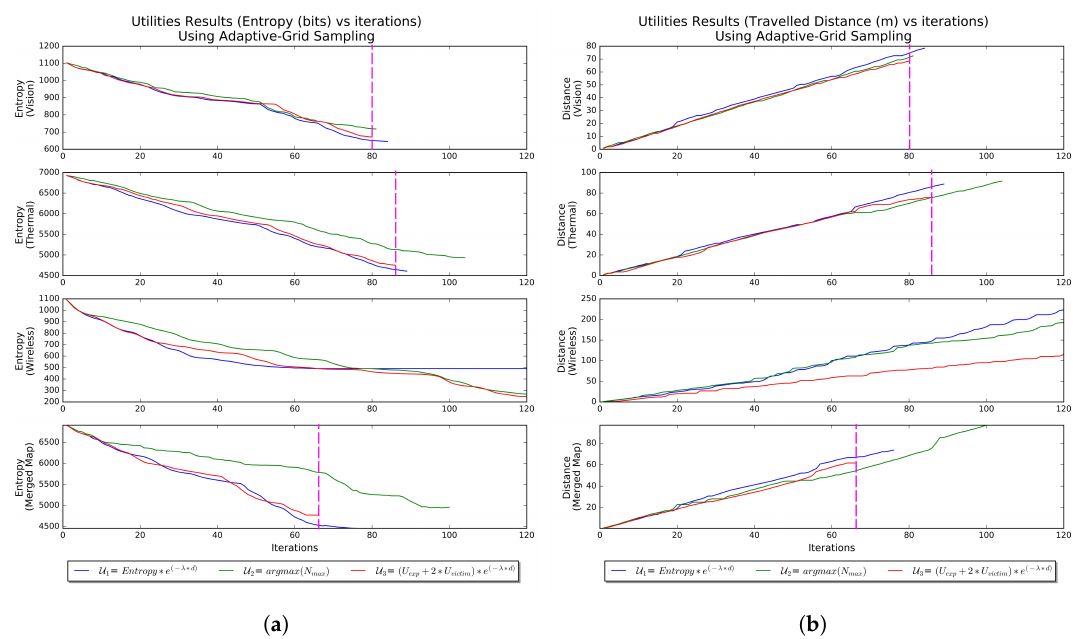
Figure 14. Regular Adaptive Grid Sampling Approach Results. ( a ) Entropy vs. Iteration using Adaptive Grid Sampling Approach. The fastest method is indicated by the magenta vertical dash line. ( b ) Travel distance vs. Iteration using Adaptive Grid Sampling Approach. The fastest method is indicated by the magenta vertical dash line.